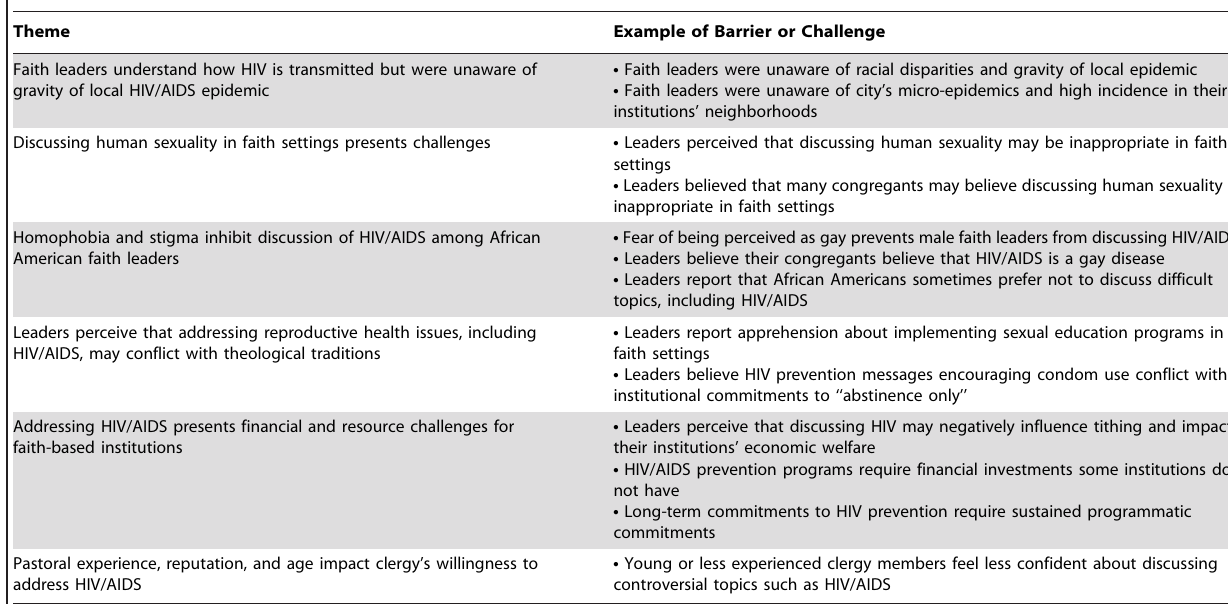
Table 2. Barriers and Challenges to Engaging African American Faith-Based Institutions in HIV Prevention.